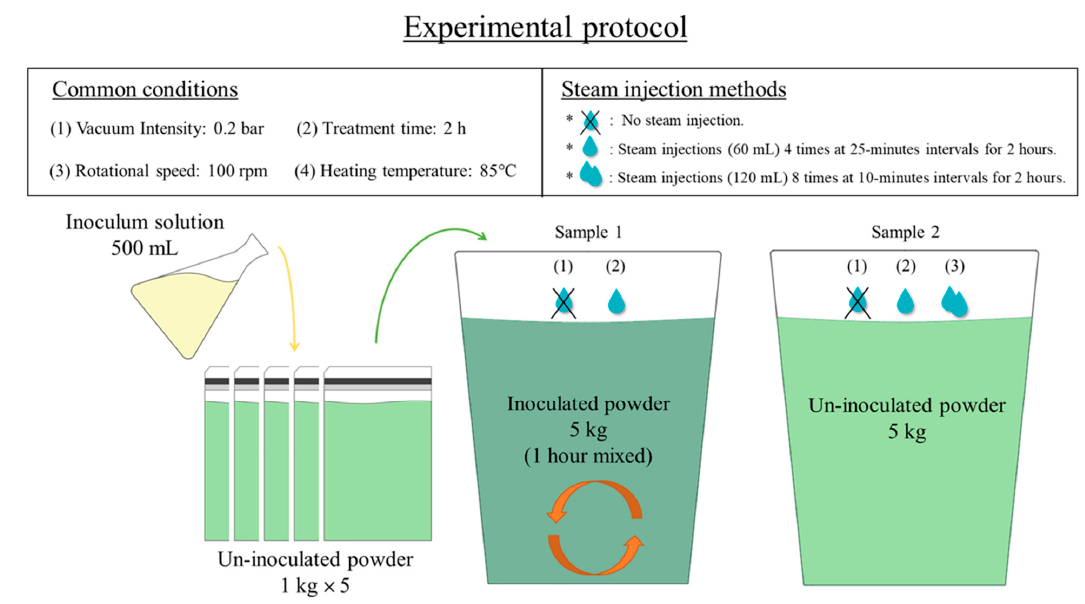
Figure 7. Schematic diagram of the experimental protocol.